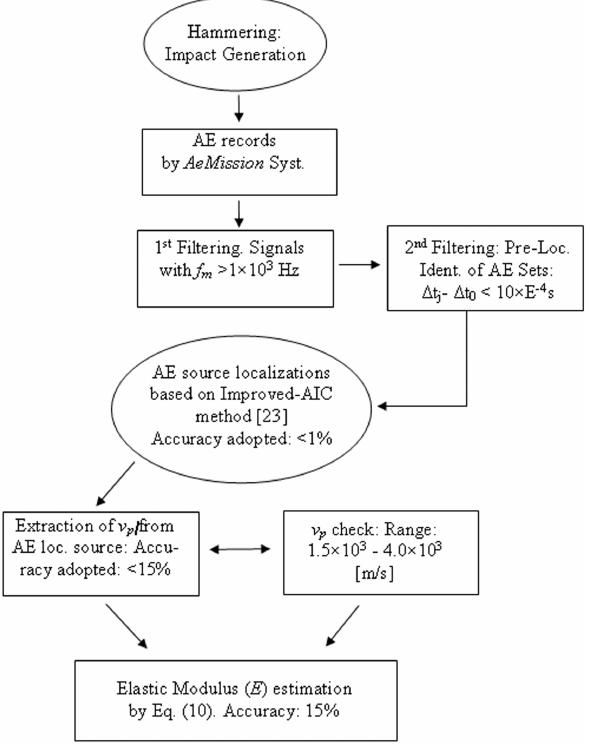
Figure 7: Flow-chart of the elastic modulus estimation by v p mea- surements. Different steps are performed to reduce measurement errors. The localization procedure leading to the v on the improved Akaike algorithm Criterion as reported in [23]